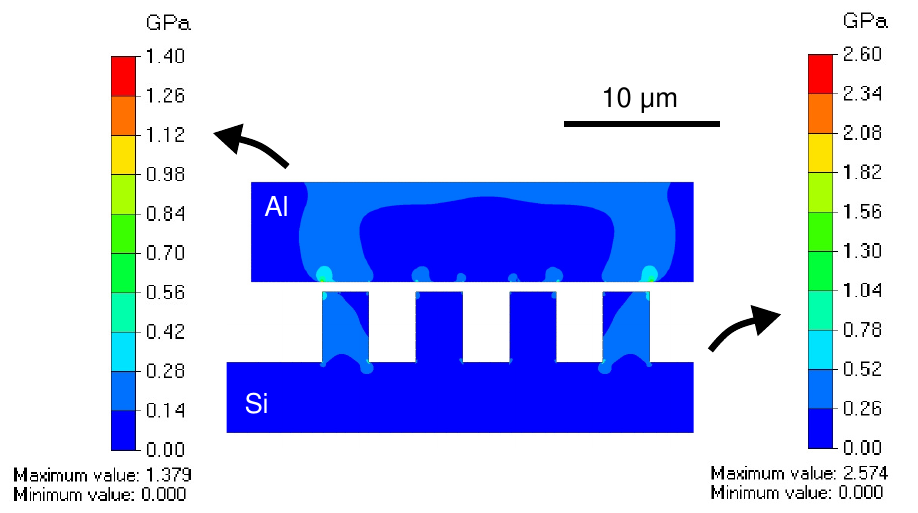
Figure 7. Finite element analysis of the cross-section showing the stress distribution along the bonding frame at the beginning of the bonding